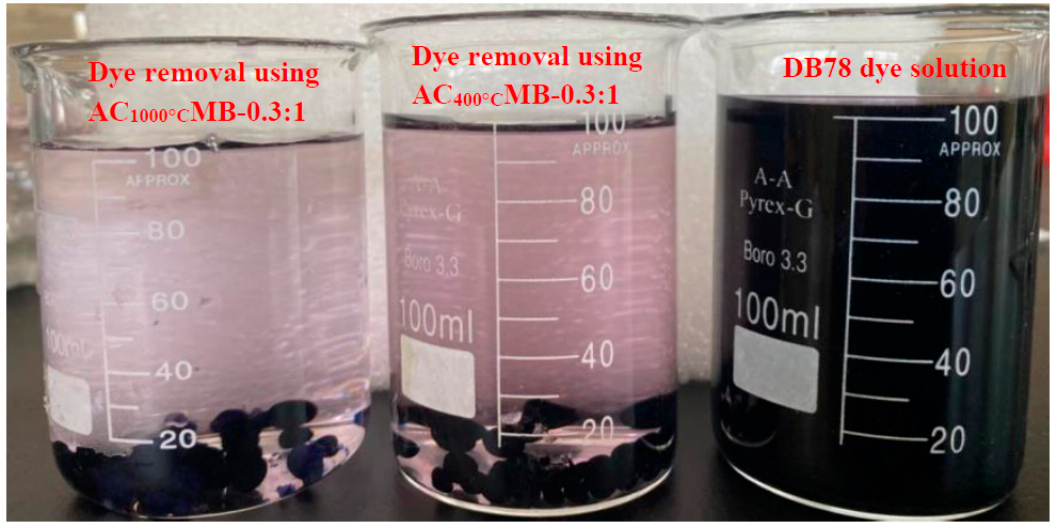
Figure 13. DB78 dye solution and dye removal using AC 1000°C MB-0.3:1 and AC 400°C MB-0.3:1.